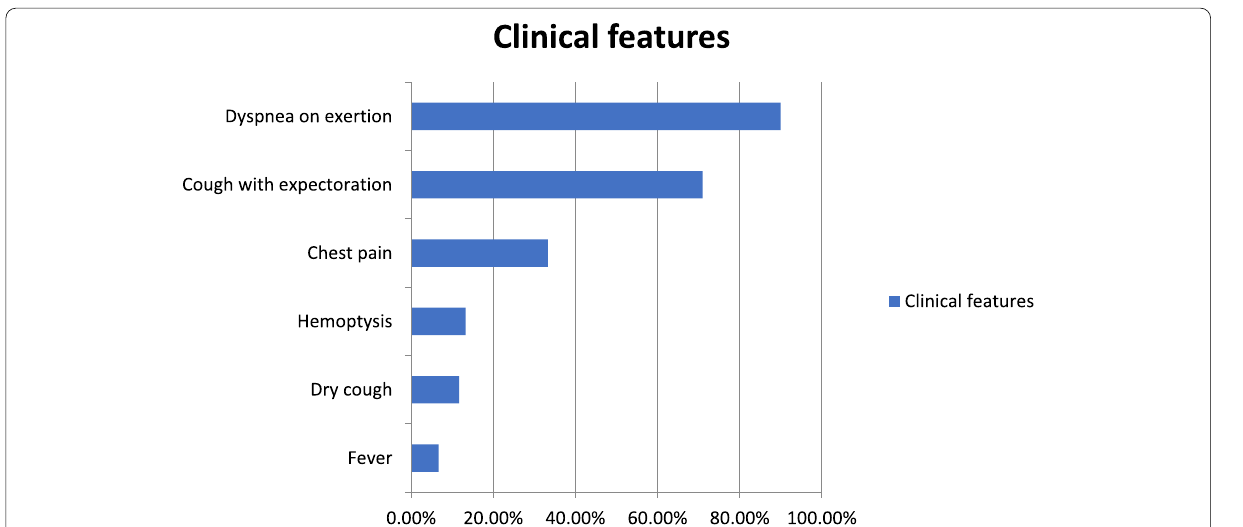
Fig. 4 Distribution of cases as per clinical